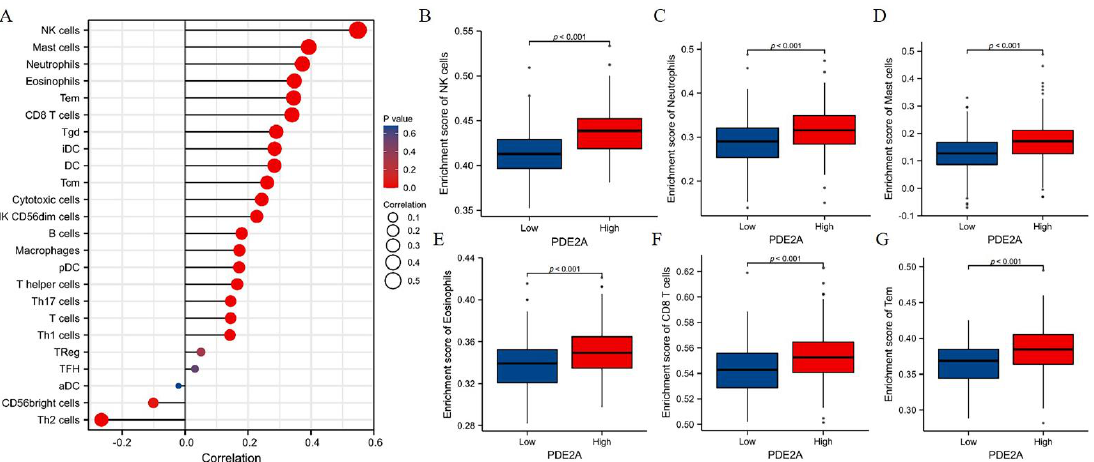
Figure 3. Correlation between PDE2A expression and Immune Cell Infiltration in HCC. ( A ) Relationships between infiltration levels of 24 immune cell types and PDE2A expression profiles by Spearman’s analysis. ( B − G ) The comparison of infiltration levels of most correlated immune cells between high − and low − PDE2A expression groups, including NK cells ( B ), neutrophils ( C ), mast cells ( D ), Eosinophils ( E ), CD8 T cells ( F ), and Tem ( G ). DCs, dendritic cells; aDCs, activated DCs; iDCs, immature DCs; pDCs, plasmacytoid DCs; Th, T helper cells; Th1, type 1 Th cells; Th2, type 2 Th cells; Th17, type 17 Th cells; Treg, regulatory T cells; Tgd, T gamma delta; Tcm, T central memory; Tem, T effector memory; Tfh, T follicular helper; NK, natural killer.